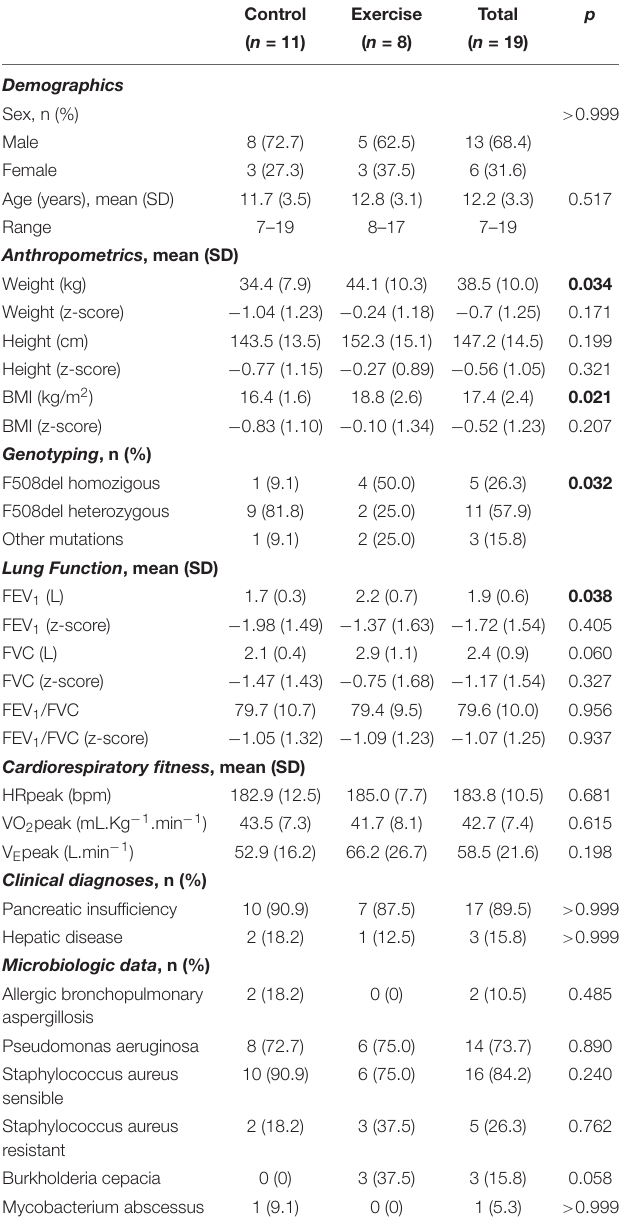
TABLE 1 | Characteristics of the study sample. Control Exercise